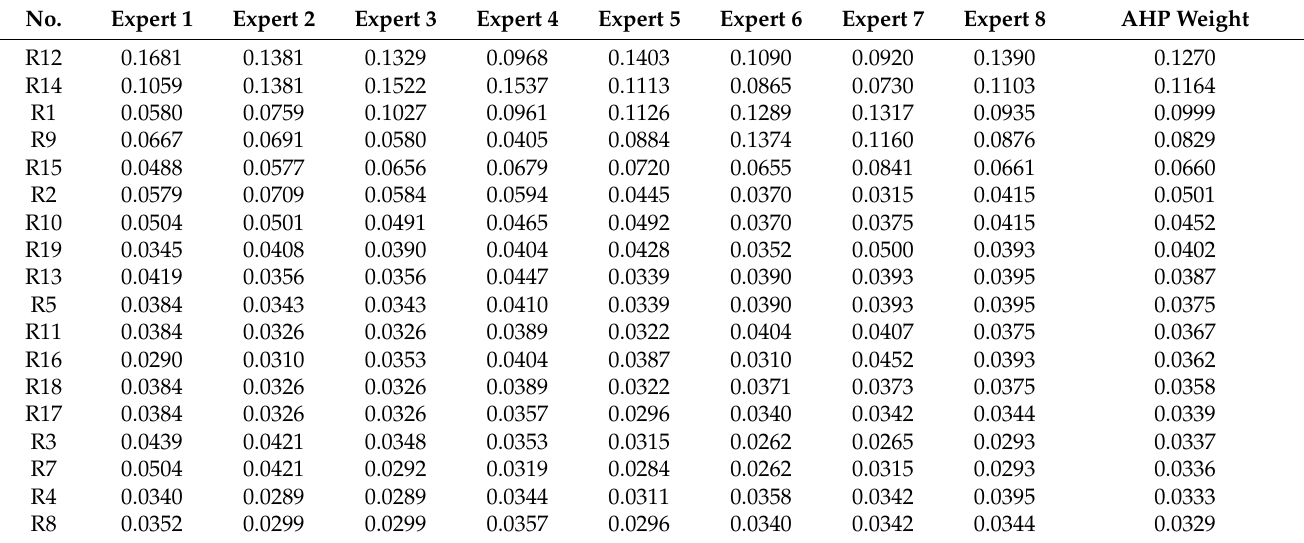
Table 7. The final weight of each SSCR.